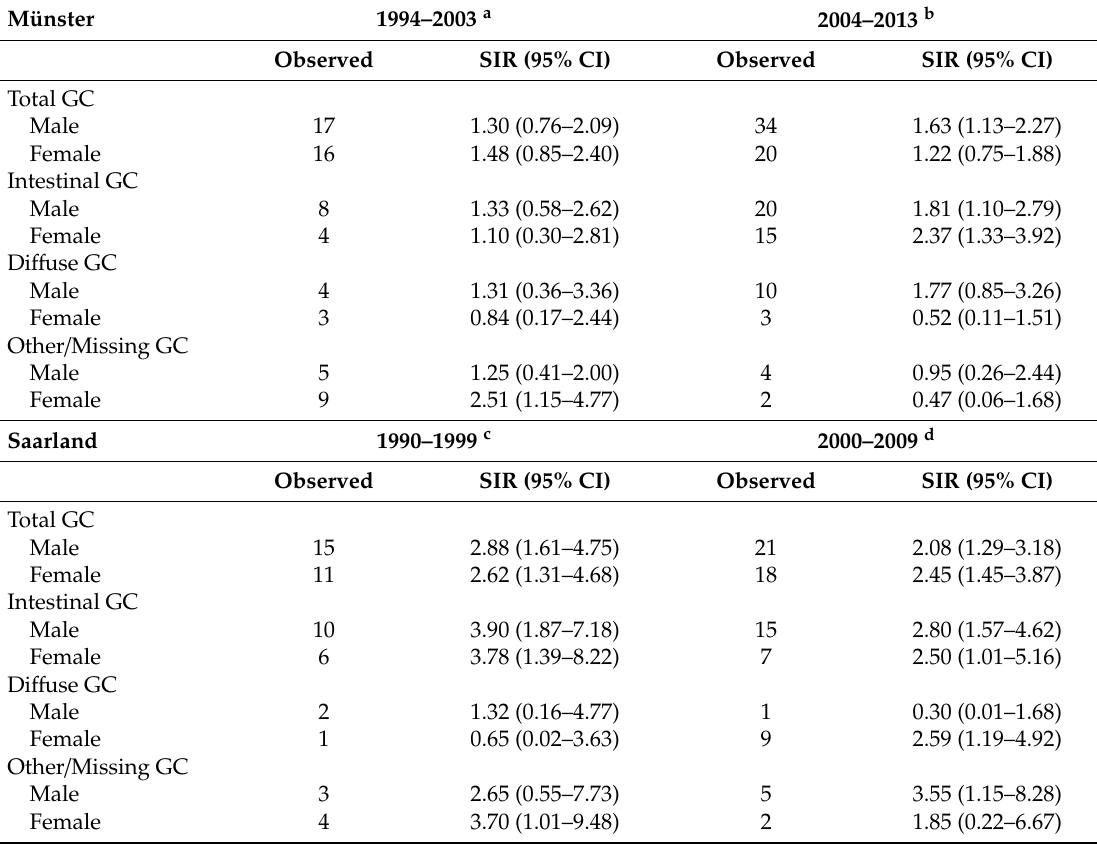
Table A1. Standardized incidence ratios for subtypes of gastric cancer among resettlers compared to the general population in Münster and Saarland